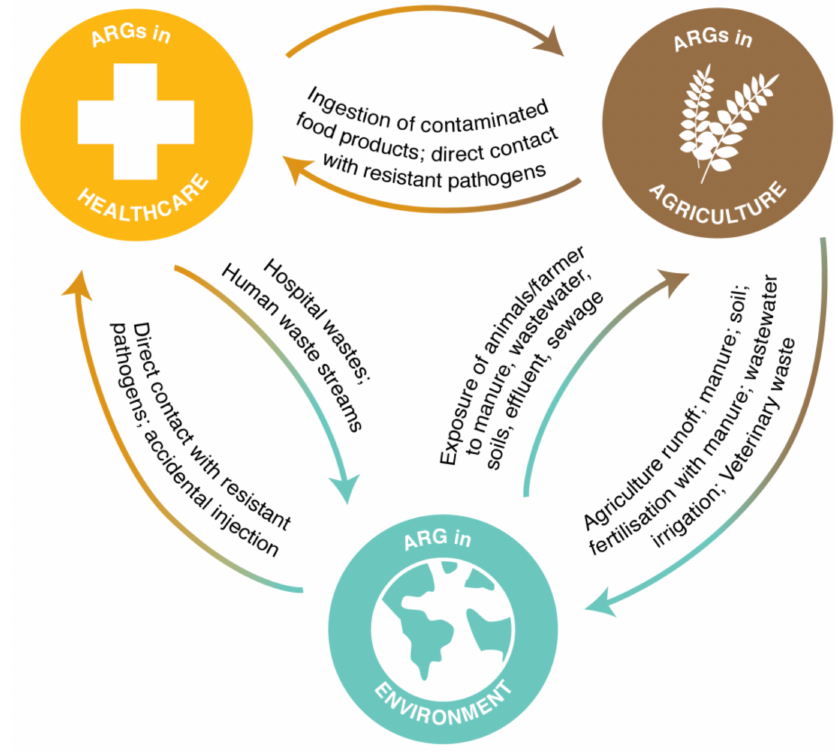
Figure 1. Commonly cited AMR transmission routes for antibiotic resistance genes (ARGs) between healthcare, agricultural and environmental